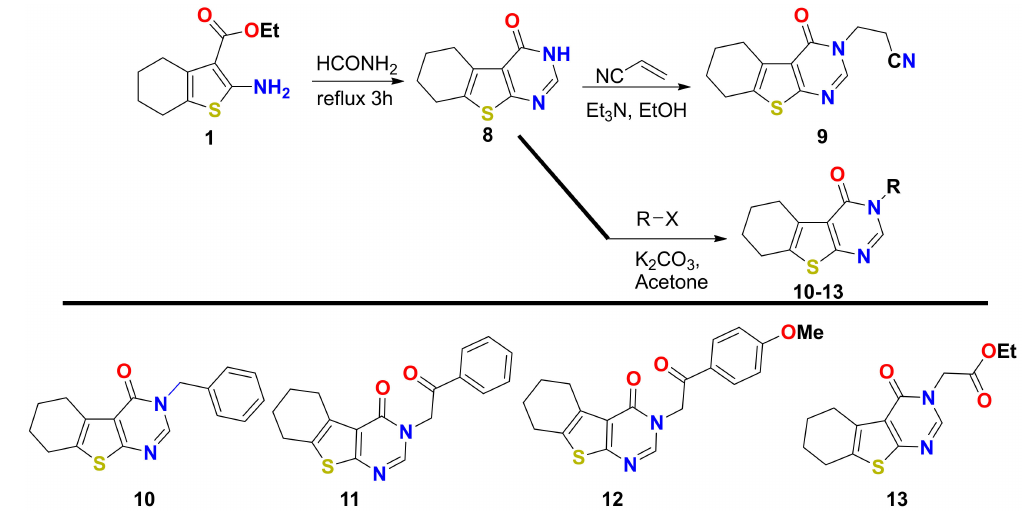
Scheme 3. Alkylation of pyrimidinone 8 with di ff erent alkylating